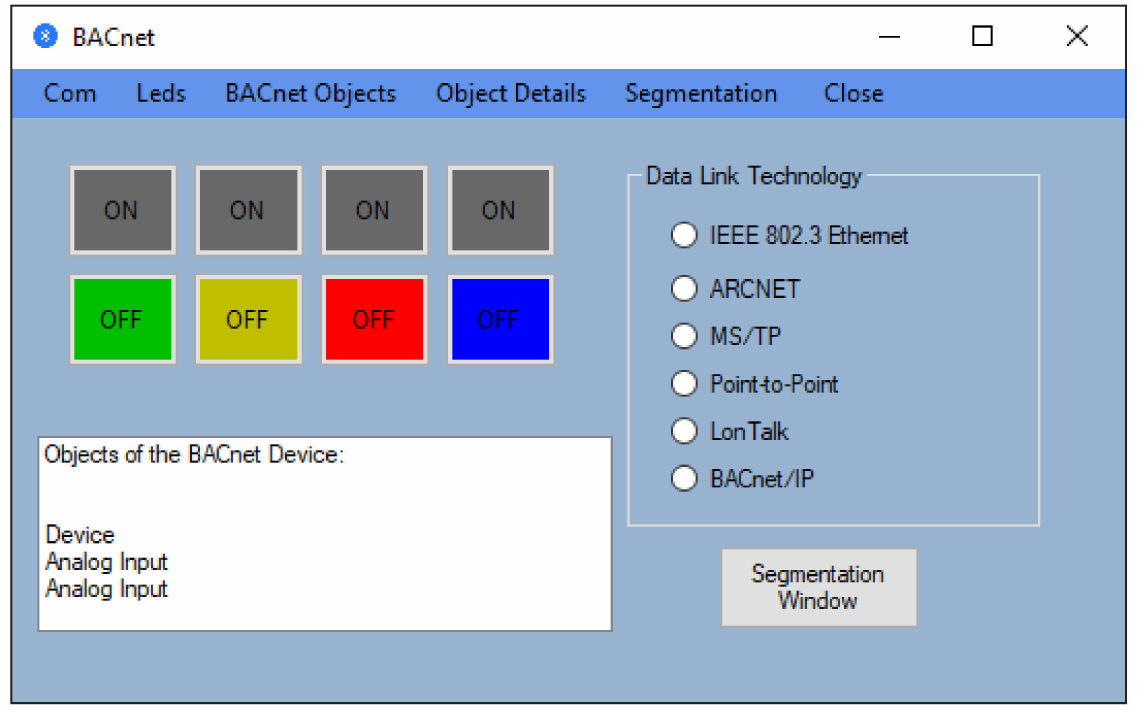
Figure 5. The BACnet objects provided by the